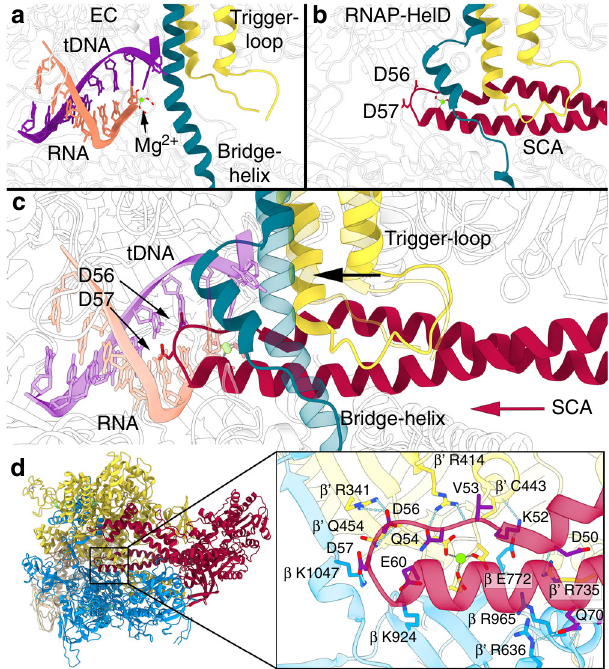
Fig. 5 HelD interactions with RNAP. a View of the active site region of the EC with the bridge-helix in teal, trigger-loop in yellow, template DNA strand in purple and RNA in orange. b The same view of the active site region of the RNAP-HelD complex with the SCA of HelD shown in red with the acidic D56 and D57 residues shown as sticks. c An overlay of the regions shown in a and b with the insertion of the SCA into the secondary channel indicated by the red arrow. EC elements are shown semi-transparent with nucleic acids coloured according to the scheme in Fig. 1. The bridge-helix and trigger-loop elements that are distorted by the SCA are shown, with the direction of movement from EC to HelD complex indicated by the black arrow. The catalytic Mg 2 + ion is shown as a green sphere. d Hydrogen- bond and salt-bridge interactions (dashed blue lines) between the tip of the SCA (red semi-transparent cartoon with purple sticks) and RNAP. Subunit colouring is the same as in Fig. 1. The conserved active site Asp residues that chelate the catalytic Mg 2 + (green sphere, grey dashed lines) are also shown to illustrate how the tip of the SCA cages but does not interact directly with residues involved in RNAP catalysis. The enlarged box on the right corresponds to the boxed region shown for the whole complex on the left.